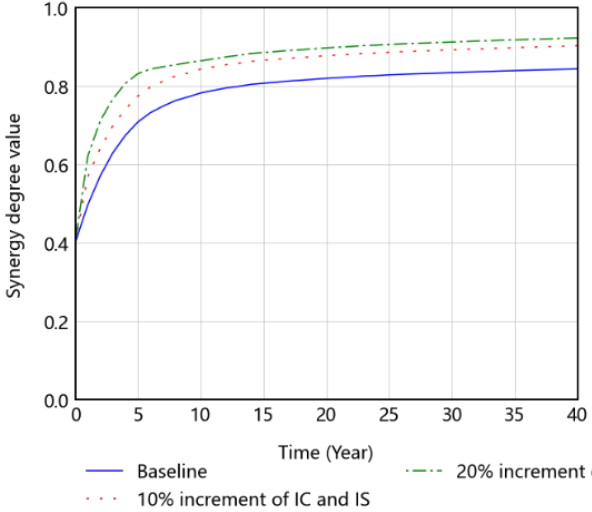
Figure 17. The effects of different degrees of IC and IS on synergy.